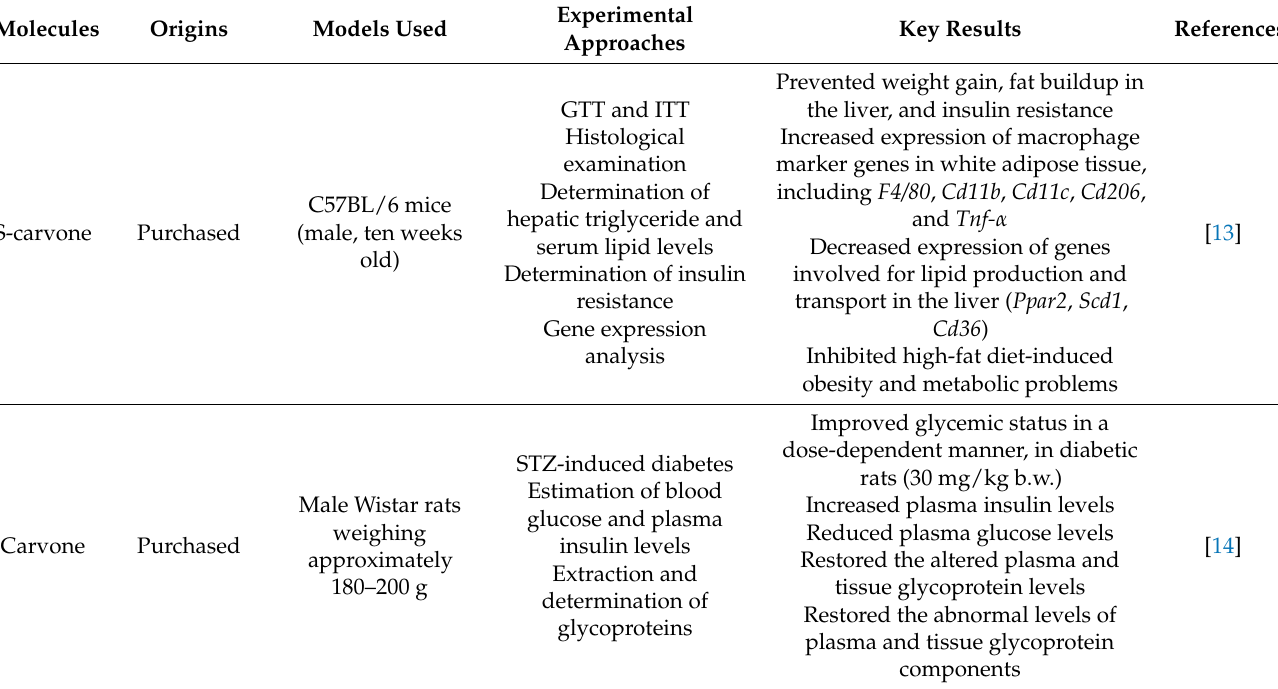
Table 2. Antidiabetic activity of